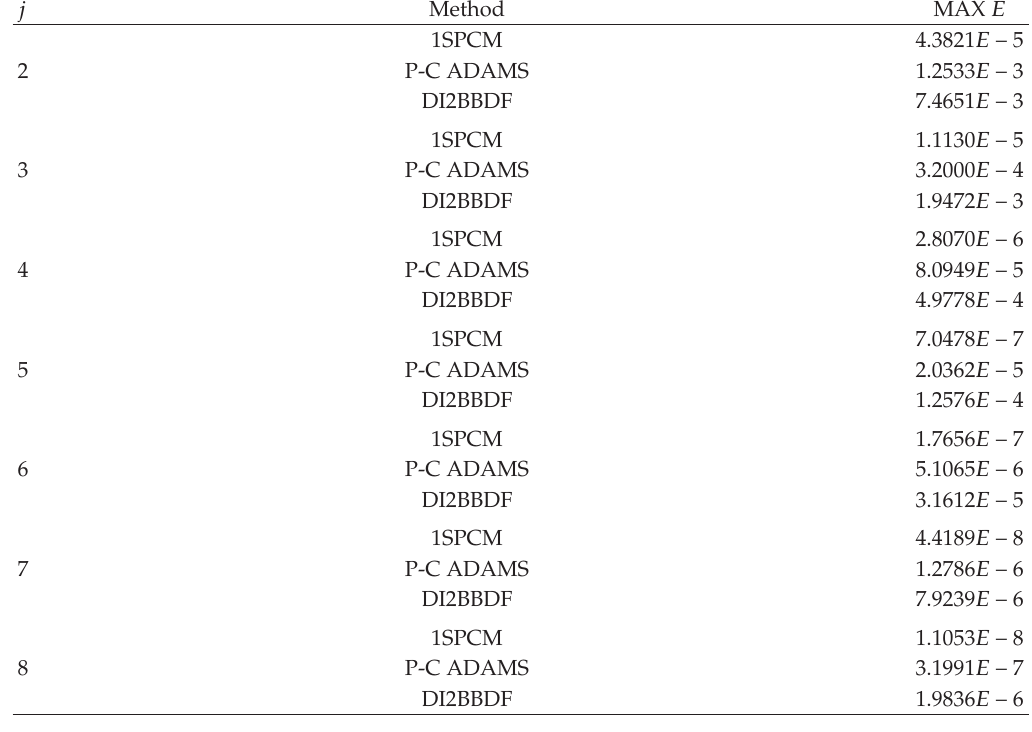
Table 1: Numerical results for problem (cid:3) 5.1 (cid:4) for di ff erent step sizes, h (cid:5) 2 − j